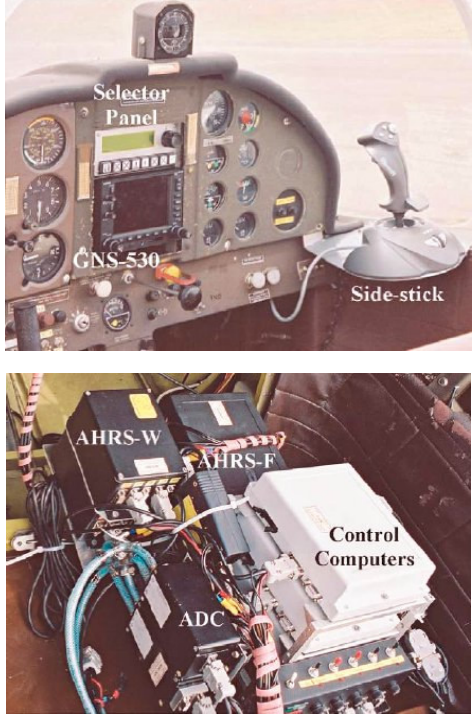
Fig 6. View of control desk and elements of indirect control system installed in the PZL-110 “Koliber”